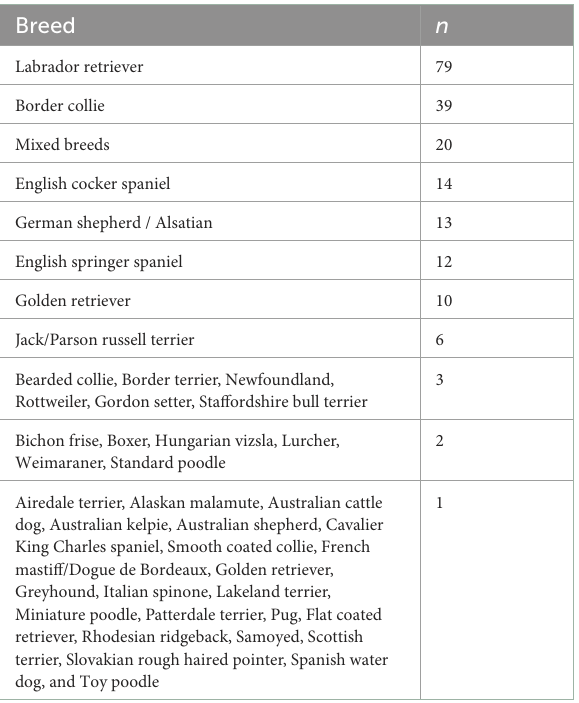
TABLE 3 Range of breeds represented in 245 dogs treated with regenerative medicine. Breed n Labrador retriever 79 Border collie 39 Mixed breeds 20 English cocker spaniel 14 German shepherd / Alsatian 13 English springer spaniel 12 Golden retriever 10 Jack/Parson russell terrier 6